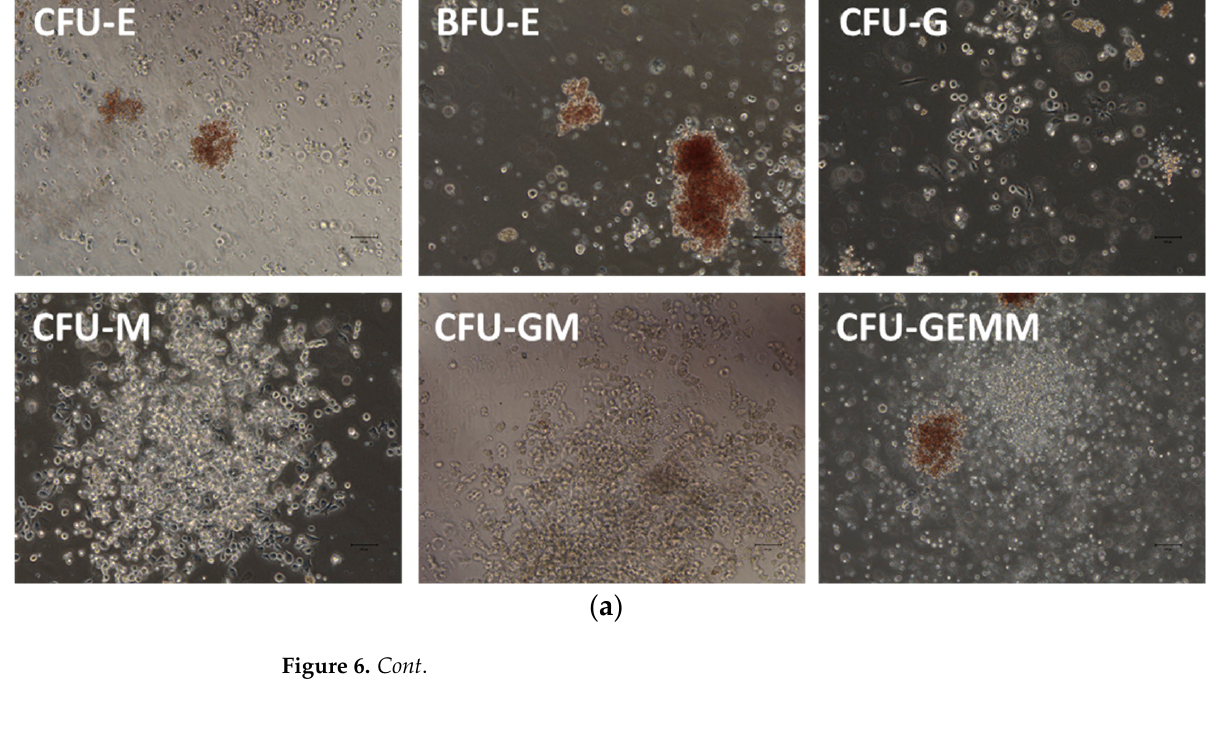
Figure 5. The effects of CBP and PL MSCs exosomes on the surface markers profile of the expanded CD34+. A total of 2 × 10 4 CB CD34 + cells were cultured (pre-expansion) and maintained under three different culture conditions for 10 days ( n = 3, 3 replicates each). Flow cytometric analysis for surface markers CD34, CD38, CD45, and Lin (surface markers cocktail of differentiated cells) was done for day 10 expanded cells: ( a ) Representative diagram for immunophenotype of subpopulations of expanded CB CD34 + cells; ( b ) representative diagram for immunophenotype of subpopulations of expanded CB CD34 + CD38 − cells; ( c ) representative diagram for immunophenotype of subpopulations of expanded CB CD34 + CD38 − Lin − cells; ( d ) representative diagram for immunophenotype of subpopulations of expanded CB CD45 + Lin + cells. * p < 0.001 compared with the control group. The fold increase represents the increase over the pre-expansion cells that were cultured.